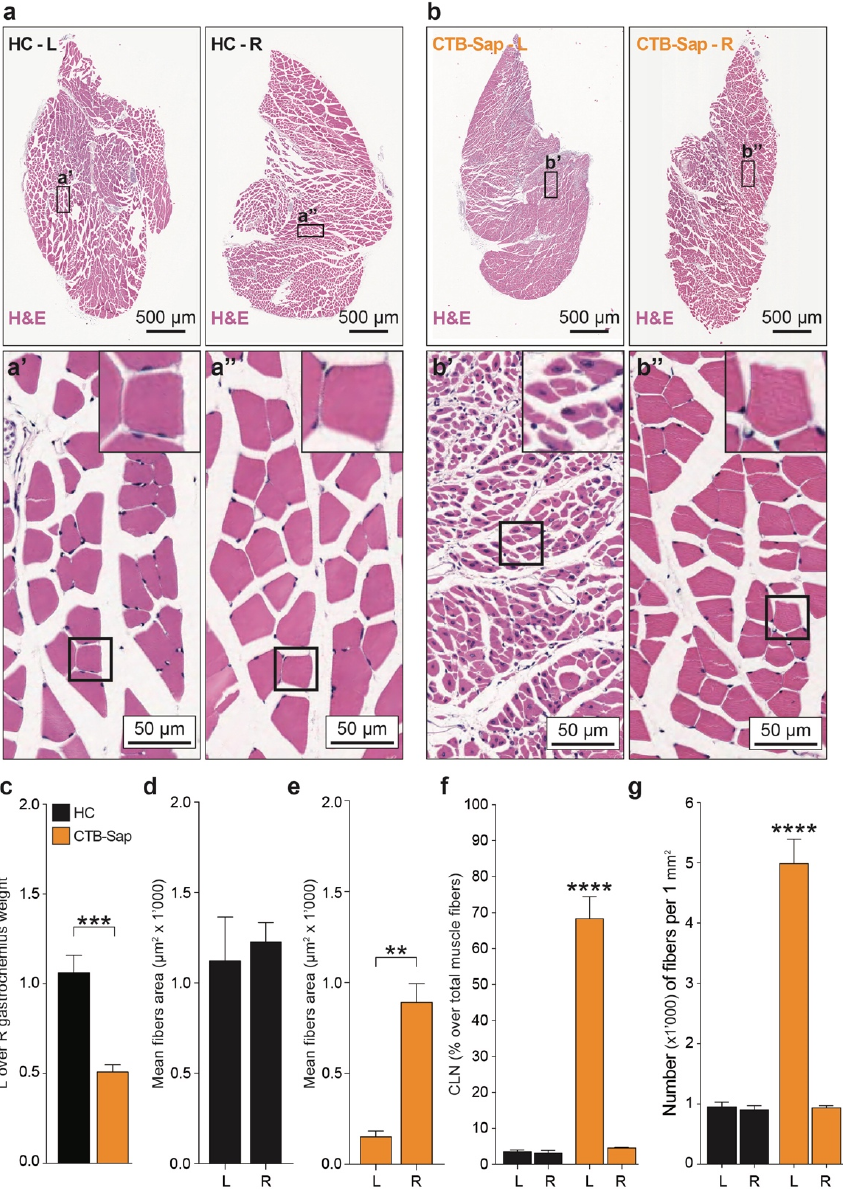
Figure 3. CTB-Sap-induced muscular changes. ( a , b ) Representative pictures of left (L) and right (R) GMs of HC ( a ) and CTB-Sap mice ( b ) and high magnification images of L ( a’ ) and R ( a’’ ) GM of HC and L ( b’ ) and R ( b’’ ) GM of CTB-Sap mice. ( c ) L over R GM weight in HC and CTB-Sap lesioned mice; data are shown as mean ± SEM; *** p -value < 0.001; unpaired t -test; ( d , e ) mean fiber area of L and R GM of HC ( d ) and CTB-Sap ( e ) mice; data are shown as mean ± SEM; ** p -value < 0.01; unpaired t -test; ( f ) centrally located nuclei (CLN) quantification in L and R GMs of HC and CTB-Sap mice; data are shown as percentage of CLN over total muscle fibers ± SEM; **** p -value < 0.0001; one-way ANOVA and Holm-Sidak’s multiple comparisons test; ( g ) number of fibers (×1000) per 1 mm 2 area in L and R GMs of HC and CTB-Sap mice; data are mean ± SEM; **** p -value < 0.0001; one-way ANOVA and Holm-Sidak’s multiple comparisons test.